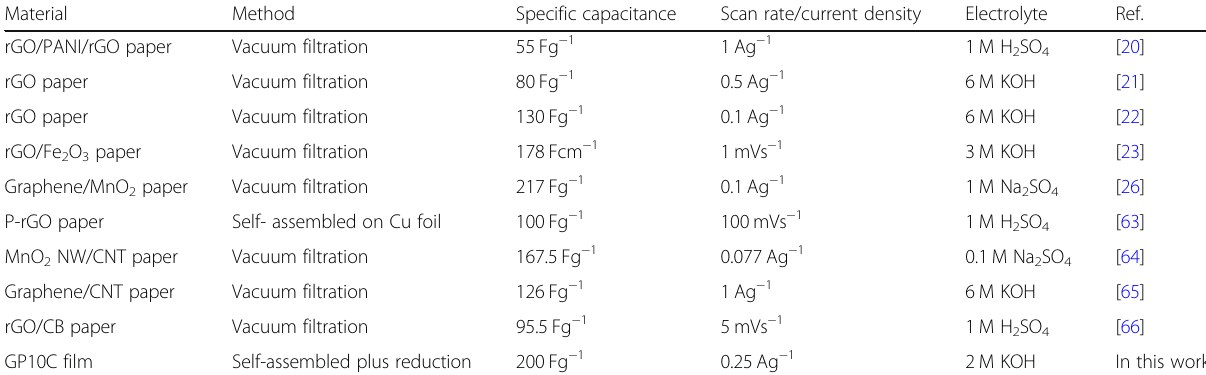
Table 1 Electrochemical performance of the GP10C electrode compared with other recently reported results in the literature Material